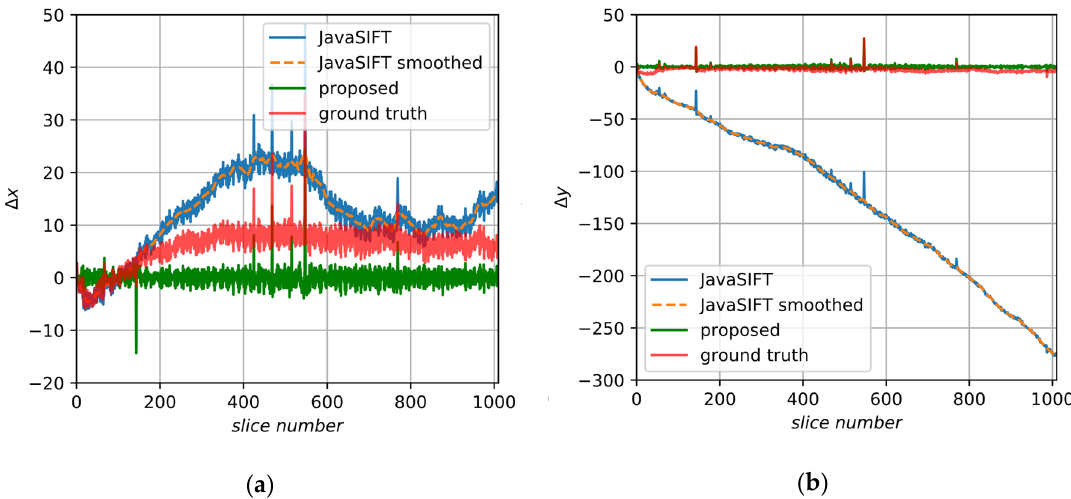
Figure 17. The displacements found by the proposed algorithm for image B: ( a ) in the X axis; ( b ) in the Y axis.